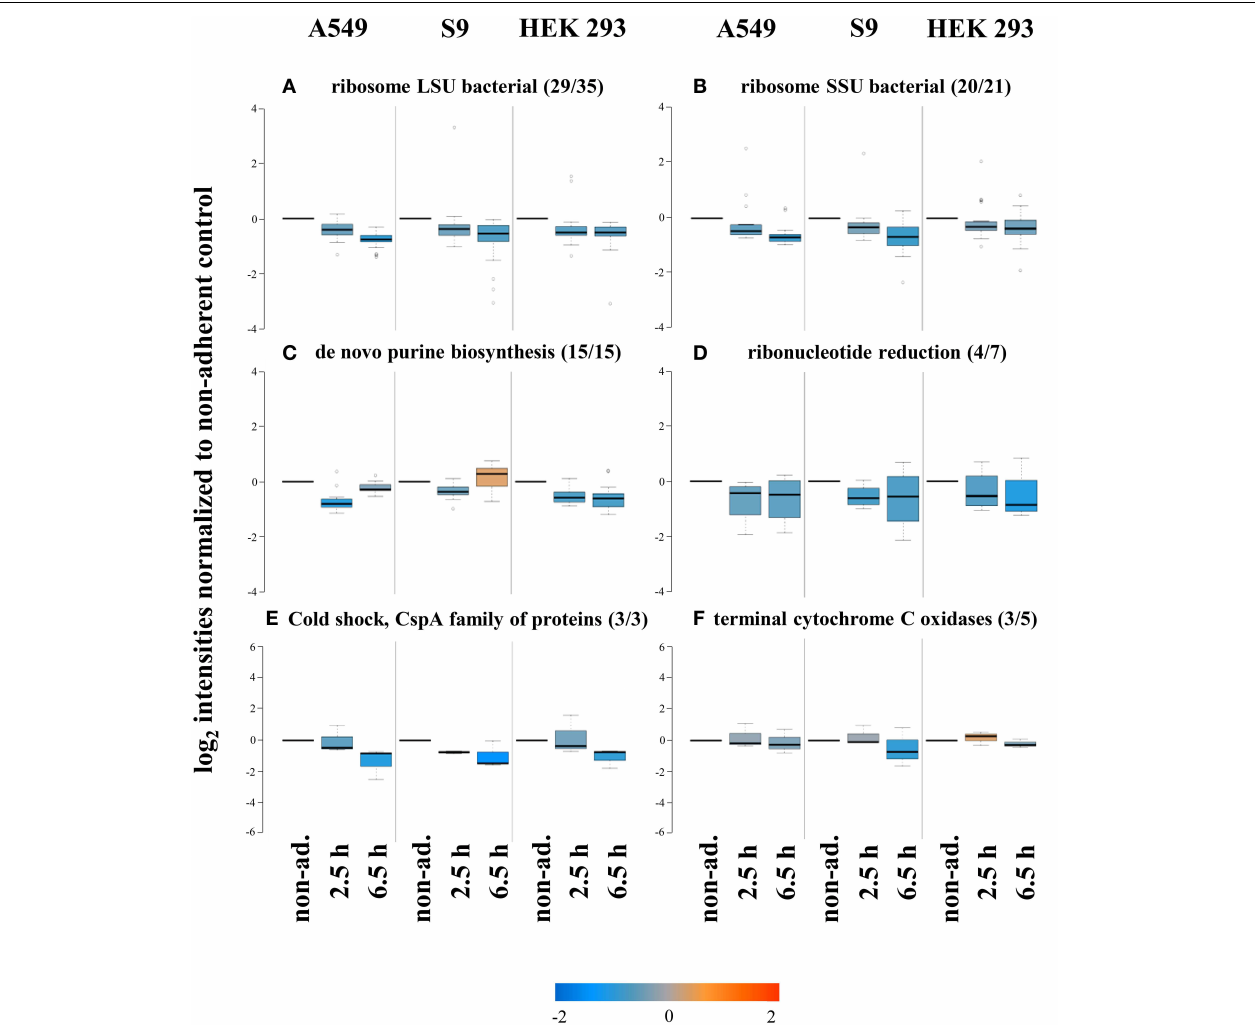
FIGURE 5 | Protein groups displaying reduced levels after internalization by all three cell lines. After internalization some proteins were found in decreased levels, among them many groups required for growth such as ribosomal proteins (A,B) , and de novo purine biosynthesis (C) . Also proteins involved in ribonucleotide reduction (D) , cold shock adaptation (E) , and those representing terminal cytochrome C oxidases (F)